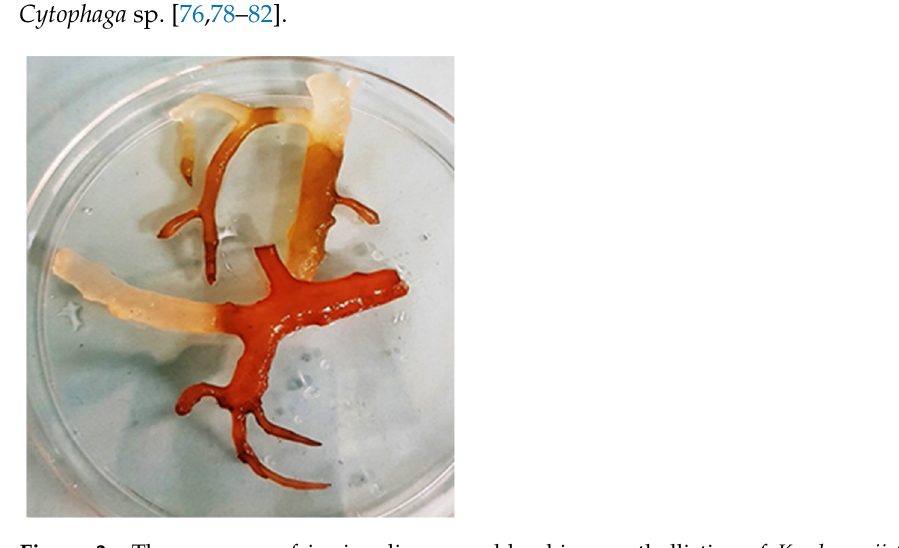
Figure 2. The main threats to seaweed production and their mitigation strategies.